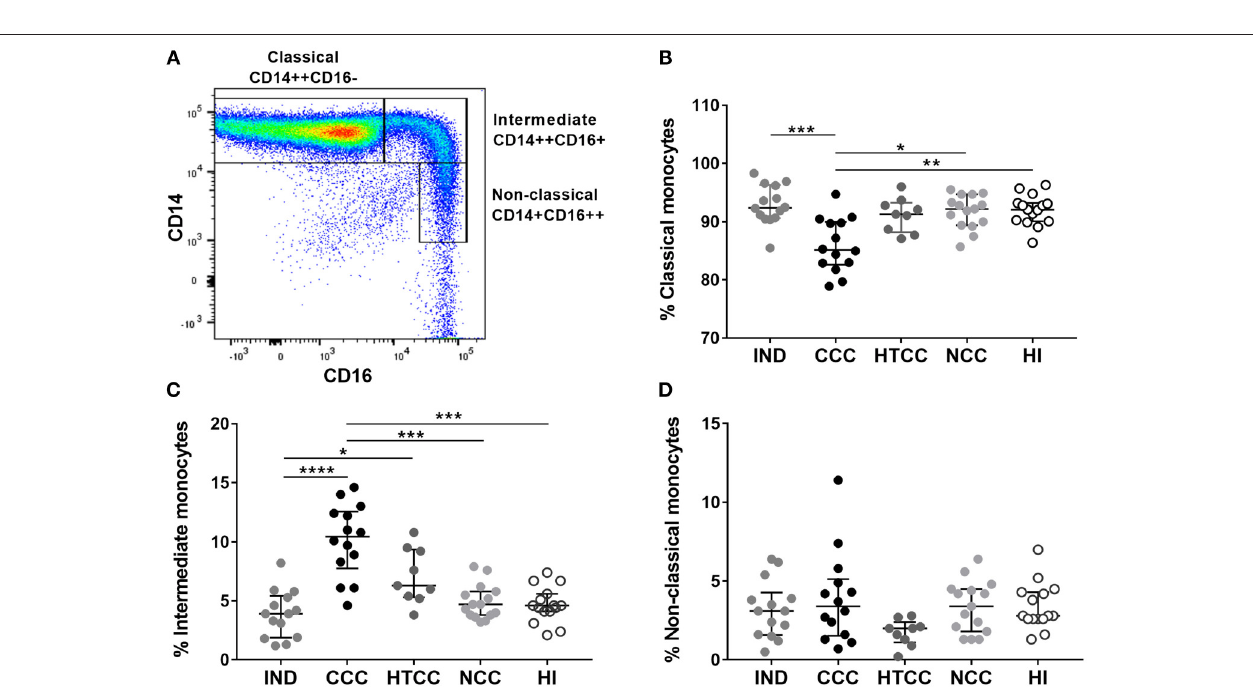
FIGURE 2 | Analysis of normalized percentages of monocyte subsets in IND ( n = 14), CCC ( n = 14), and HTCC ( n = 9) patients and NCC ( n = 15) and HI ( n = 15) controls. The strategy used to differentiate the three monocyte subsets according to CD14 and CD16 expression is shown in (A) . The percentages of classical (B) , intermediate (C) , and non-classical (D) monocytes between the groups were compared with the Kruskal-Wallis test followed by Dunn’s post-hoc test. The values are presented by median and interquartile ranges and differences are indicating with: * p < 0.05, ** p < 0.01, *** p < 0.001, **** p < 0.0001.